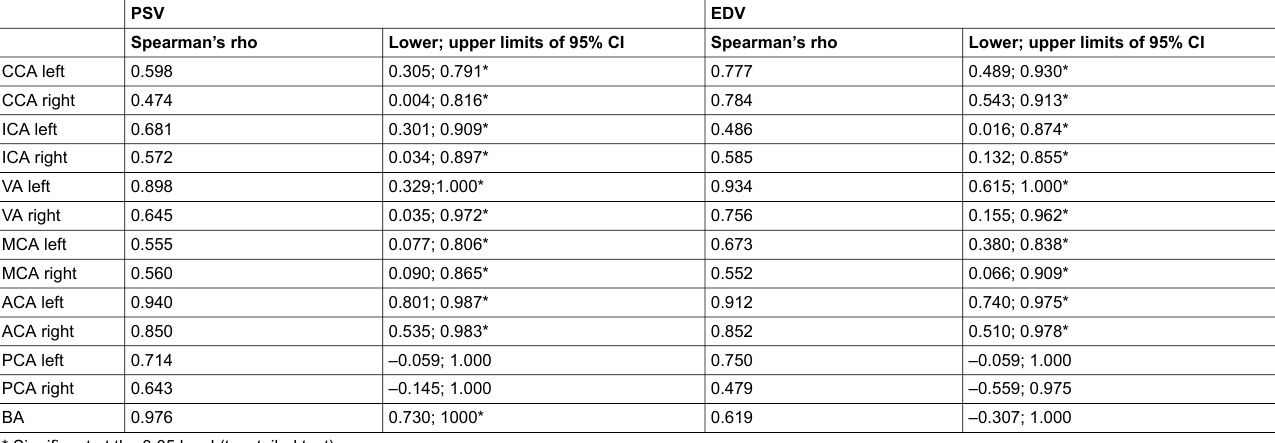
Table 3: Correlation analysis of measured velocities between colour-coded duplex sonography (CCD) and phase contrast magnetic resonance angiography (PC-MRA). PSV